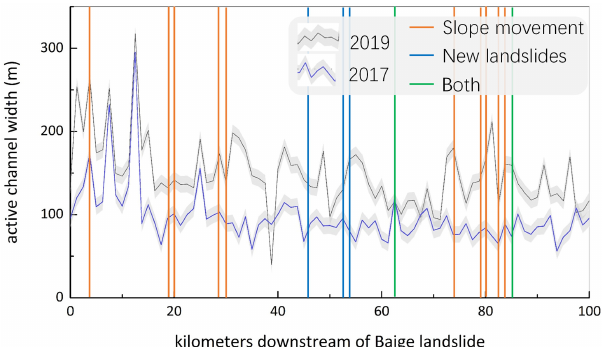
Figure 6. River widths before and after the Baige floods. The gray shading indicates an uncertainty of ± 1 pixel in the Sentinel-2 im-